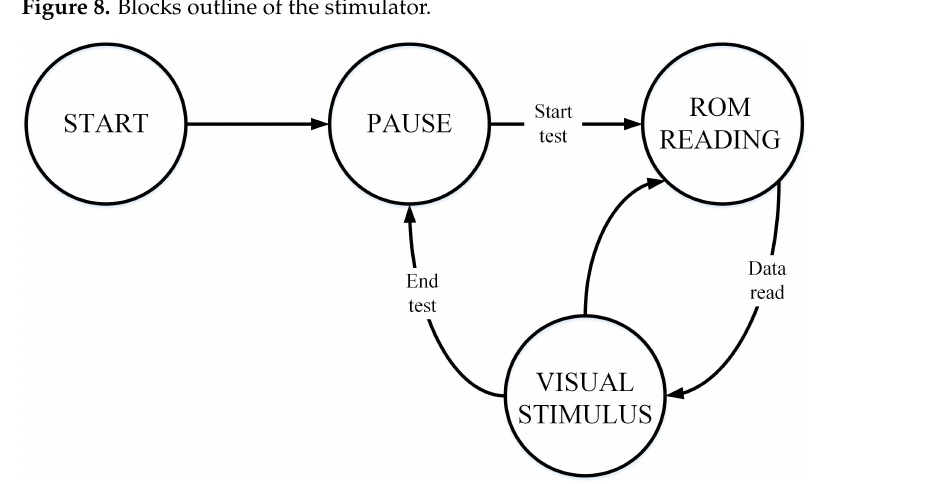
Figure 8. Blocks outline of the stimulator.